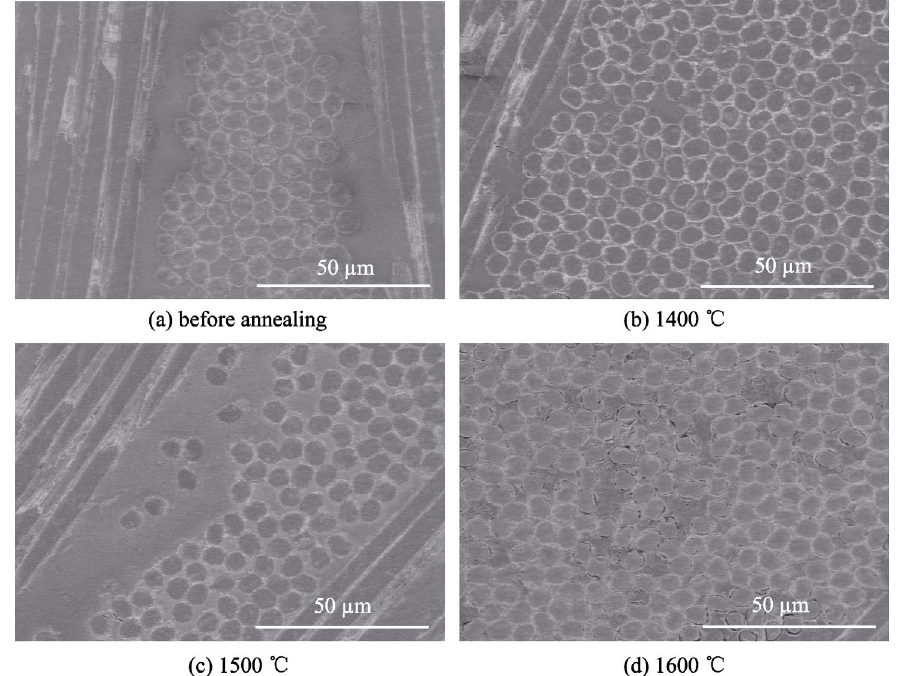
Fig. 9 Cross-section photos of the C/PyC/mullite composites (a) before annealing and after annealing at (b) 1400, (c) 1500, and (d) 1600 ℃